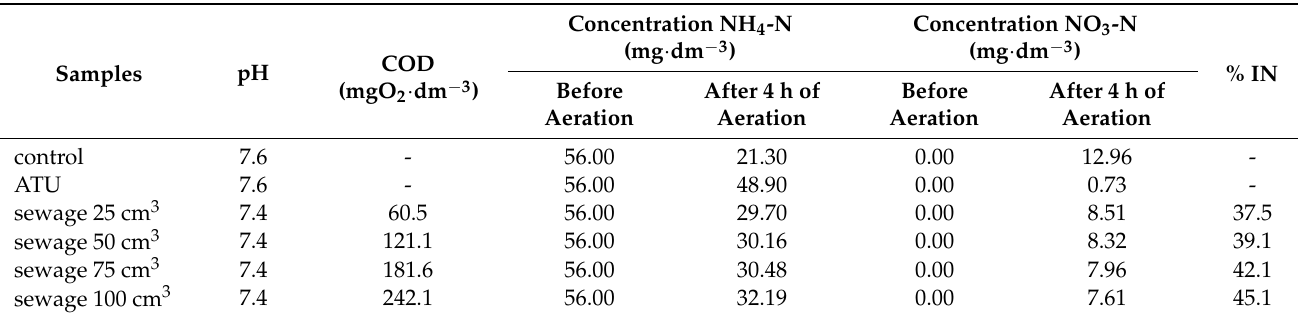
Table 8. Influence of COD of industrial wastewater from styrene production on the nitrification inhibition in activated sludge under laboratory conditions.